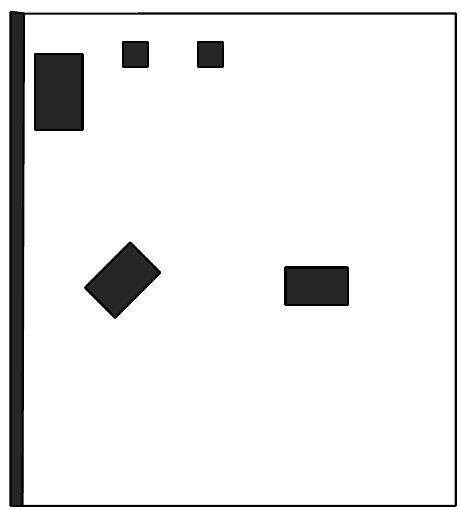
Fig. 8. Indoor environment configuration used for experiments